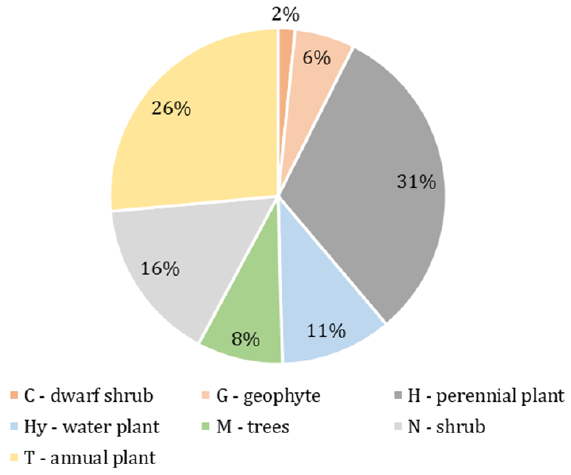
Fig. 2. Participation of the life forms in the group of 121 invasive alien plant species listed for Poland